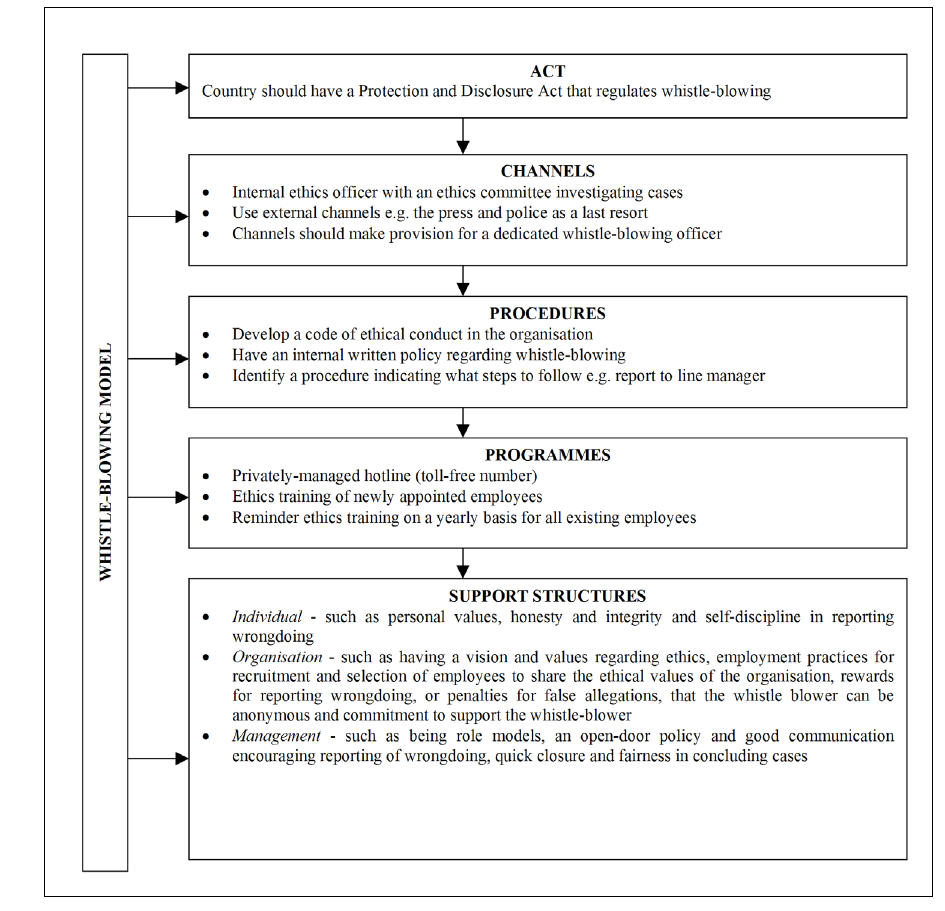
figure 3 Model for practising whistle-blowing in the